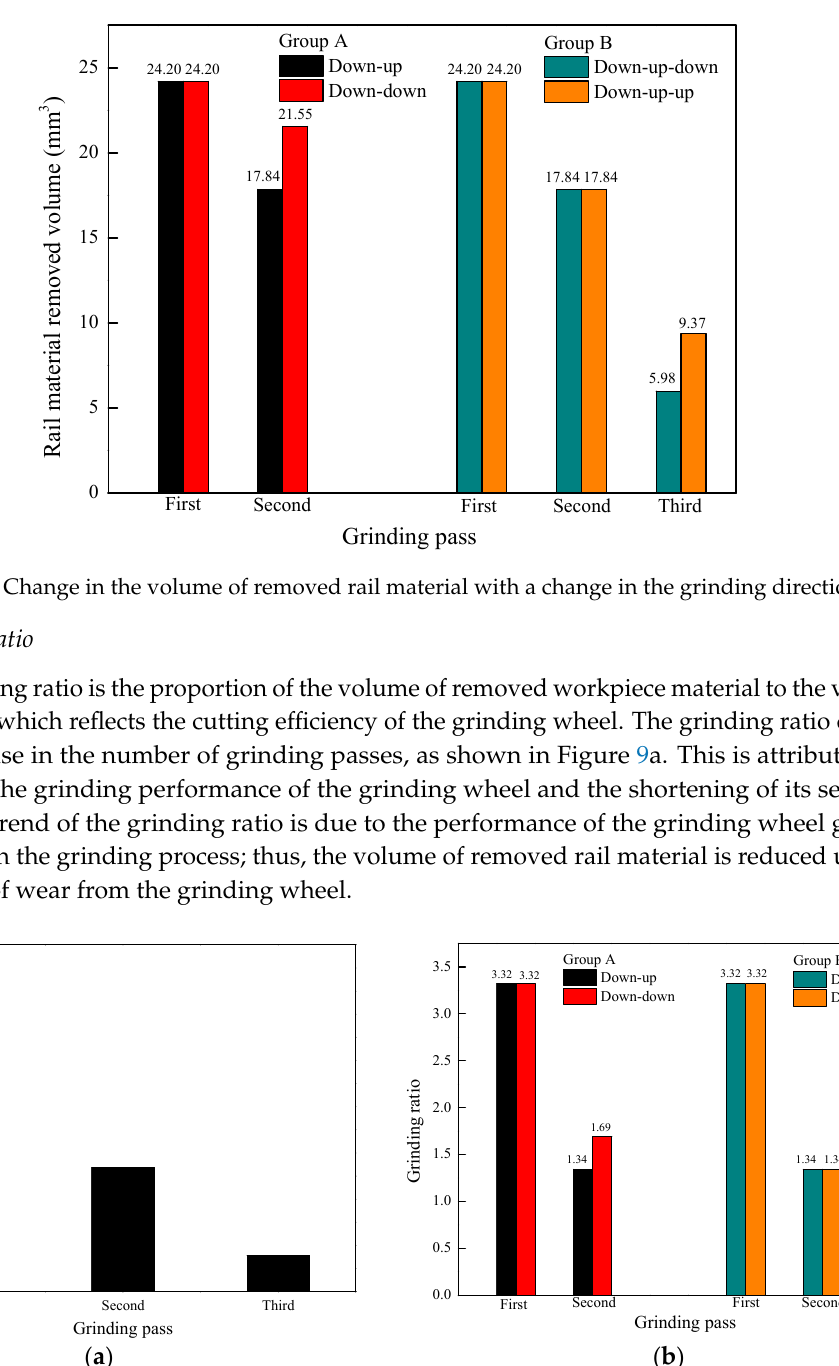
Figure 8. Change in the volume of removed rail material with a change in the grinding direction.